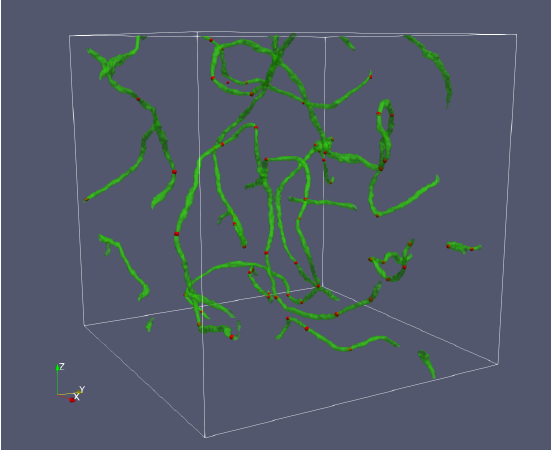
Figure 6 . Cosmic beads network, i.e., the necklace. The red and green surfaces are the isosurface of | φ = 0 . 5 v and | φ = 0 . 06 v , respectively. The figure shows that the magnetic monopoles (or 1 | 1 2 | 1 the beads) appearing as red points are connected by the cosmic